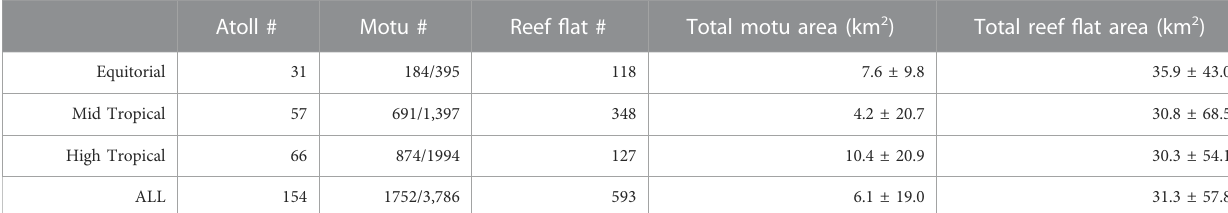
TABLE 2 Median morphometrics with one standard deviation per atoll binned by latitude for all atolls.